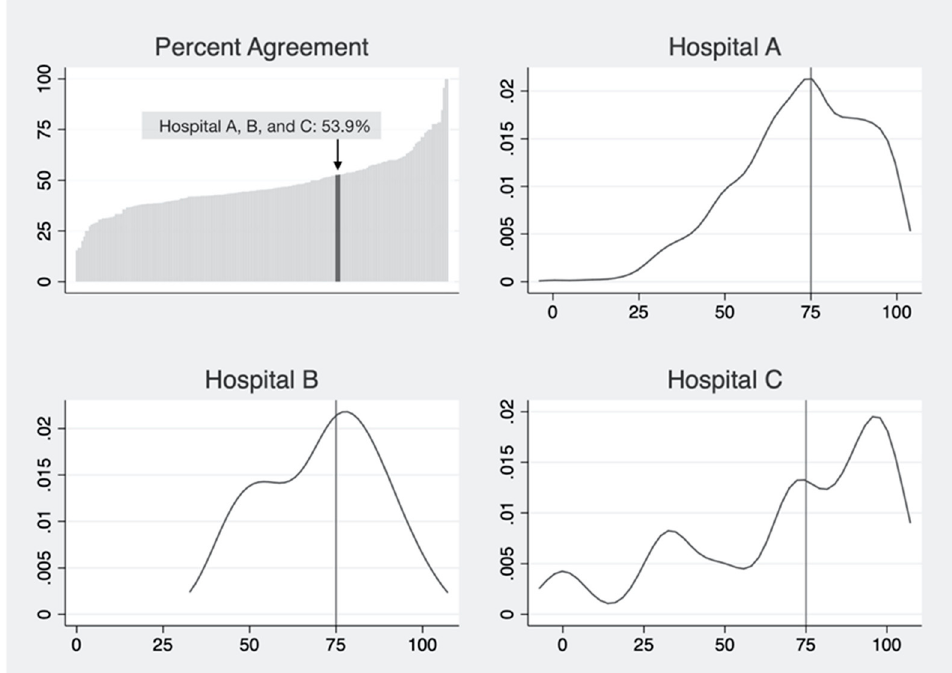
Figure 1. Percentage agreement graph and KDE plots of three individual hospitals where their teamwork climate PA are the same. Note: Each of the panels, Hospitals A, B, C, reflects a kernel density estimate (KDE) plot where the x-axis denotes 0–100 scores from a typical method of individual score calculation, and the y-axis is density. Lines going beyond 100 or below 0 are the result of bandwidth for smoothing.